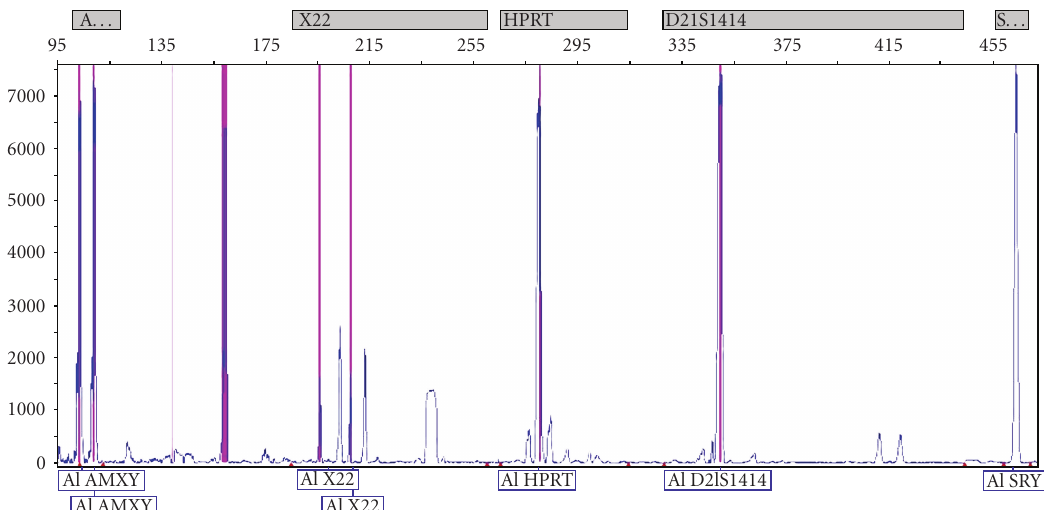
Figure 4: Electrophoretogram showing normal XY male sex chromosome constitution. Both the X- and Y- specific products of the AMXY (X-Y amelogenin gene) are present with a normal ratio of 1 :1. The XY male sex chromosome constitution is confirmed by the occurrence of the SRY product. In this example, the presence of two sex chromosomes is also further confirmed by the normal heterozygous pattern of both pseudoautosomal markers